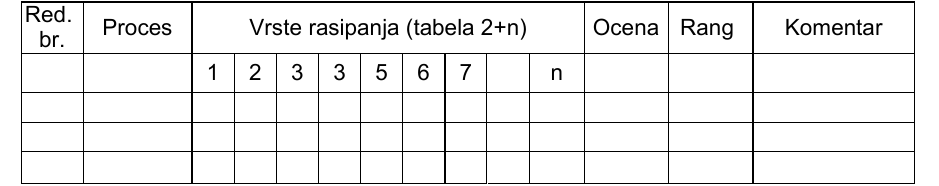
Tabela 3 – Detaljna č ek lista rasipanja Table 3 – Datailed Waste Finding Checklist Таблица 3 – Подробный обзор списка расточительства